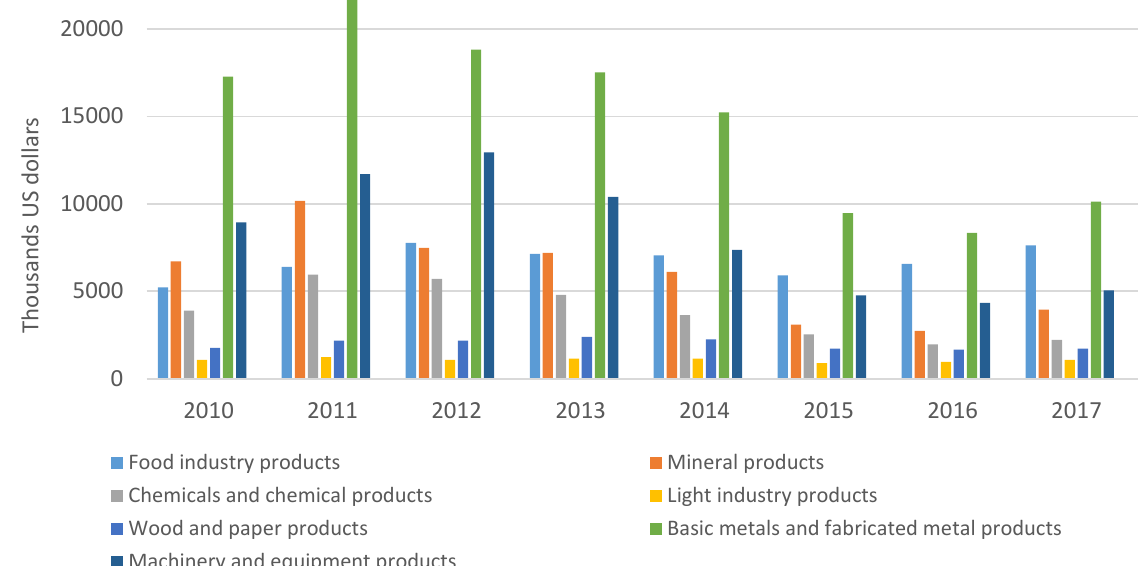
Figure 1. Ukrainian exports of industrial goods, 2010–2017